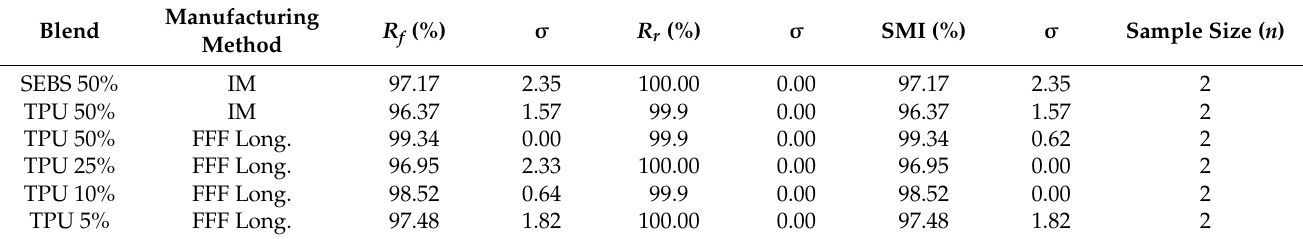
Table 4. Shape memory property values for the material systems that were subjected to a deformation/recovery cycle. Blend